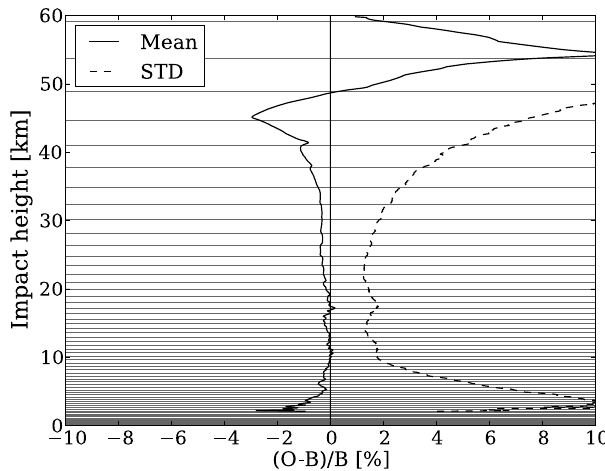
Figure 7. Bending angle innovation statistics, using a quadratic ad- justment to the exponential form of refractivity with height (Eq. 20) to produce a better approximation to the hydrostatic